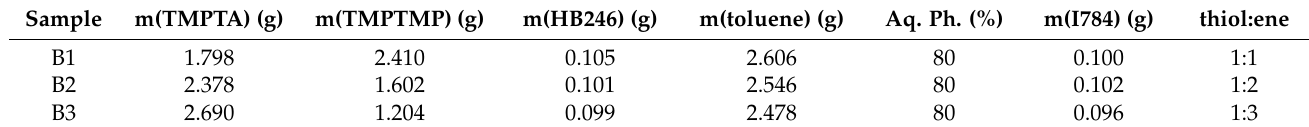
Table 2. Preparation of TMPTMP-co-TMPTA polyHIPE microspheres.